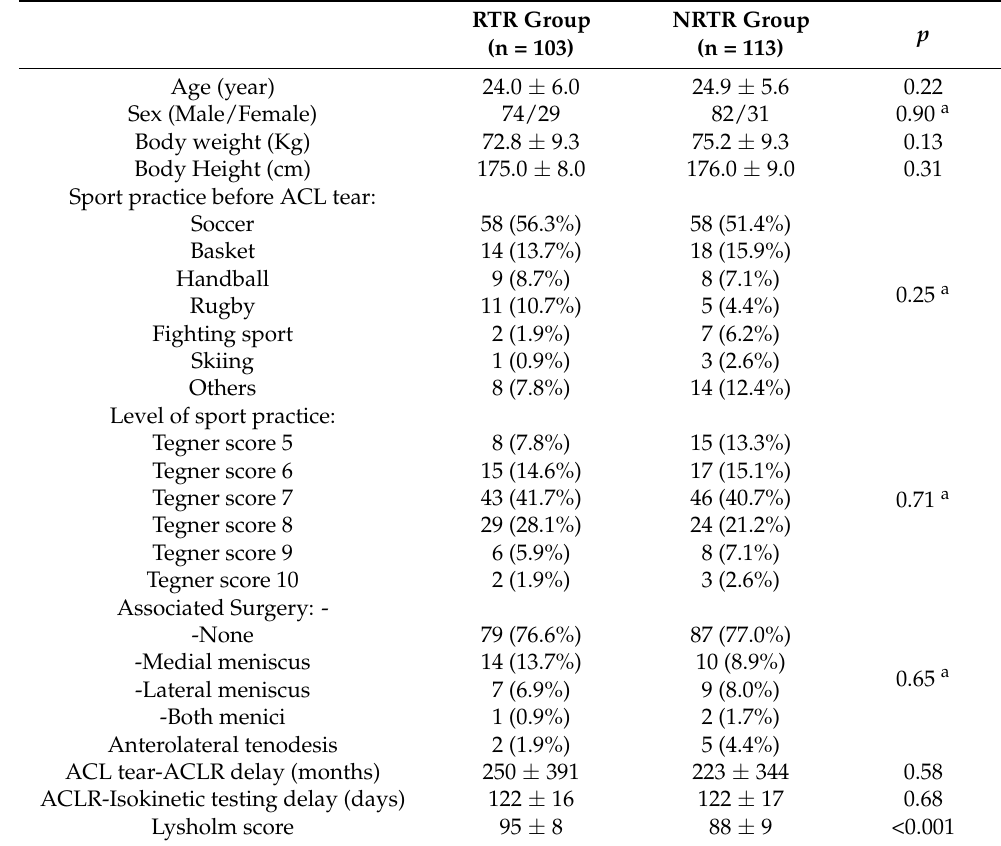
Table 1. Comparison between the group of patients who returned to running (RTR group) and those who did not (NRTR group) before isokinetic